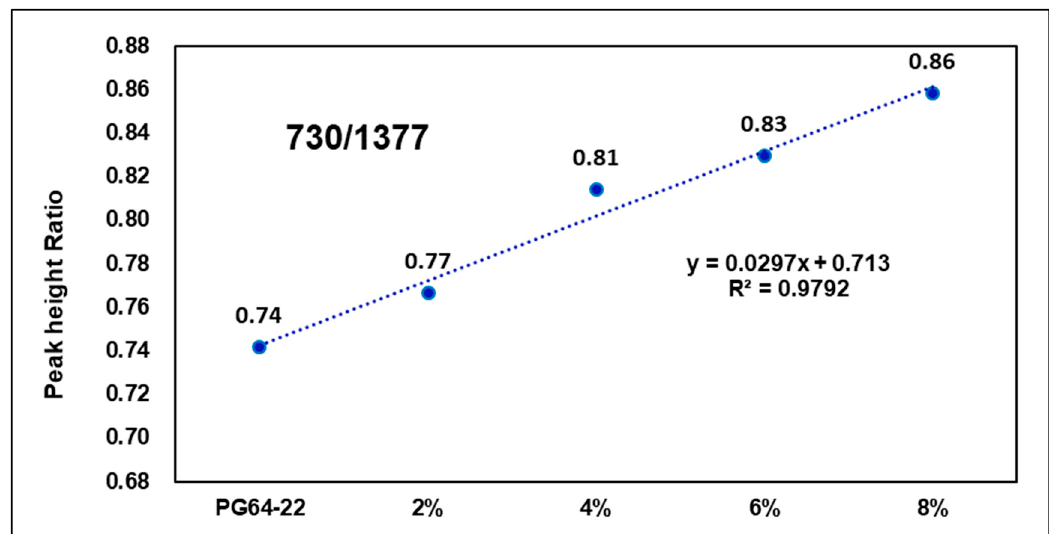
Figure 16. Warm-mix additives modified binder peak ratio (730/1377).